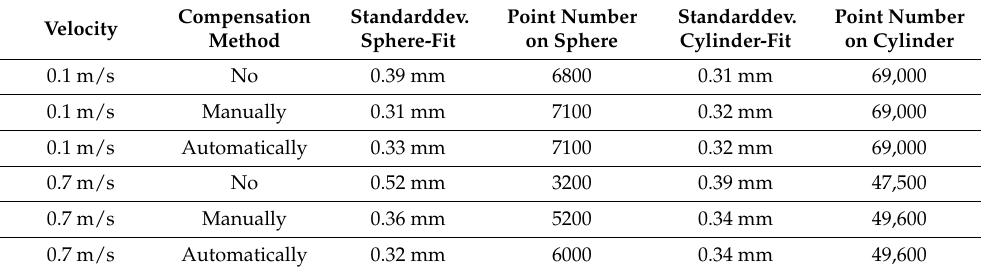
Table 3. Results of standard deviations of the 3D points from the fitted sphere and cylinder shape depending on sensor velocity and compensation